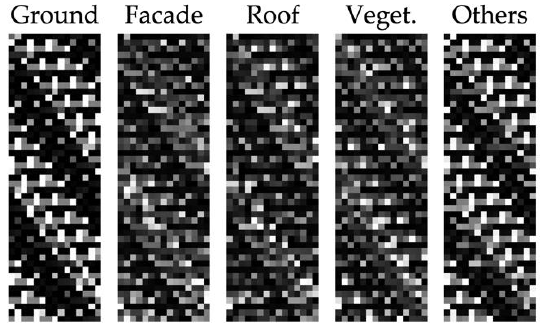
Figure 5. An example of 2D patch visualization (transposed for better